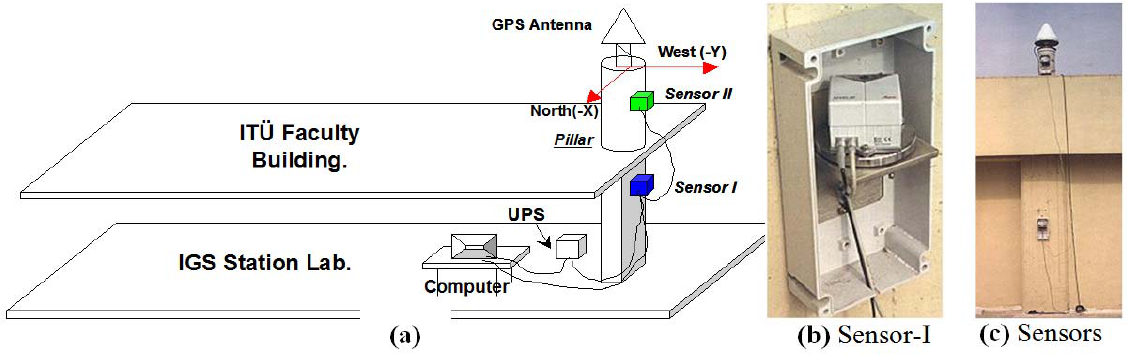
Figure 5. (a) Monitoring setup of the geodetic pillar [31], (b,c) Pictures from the campaign